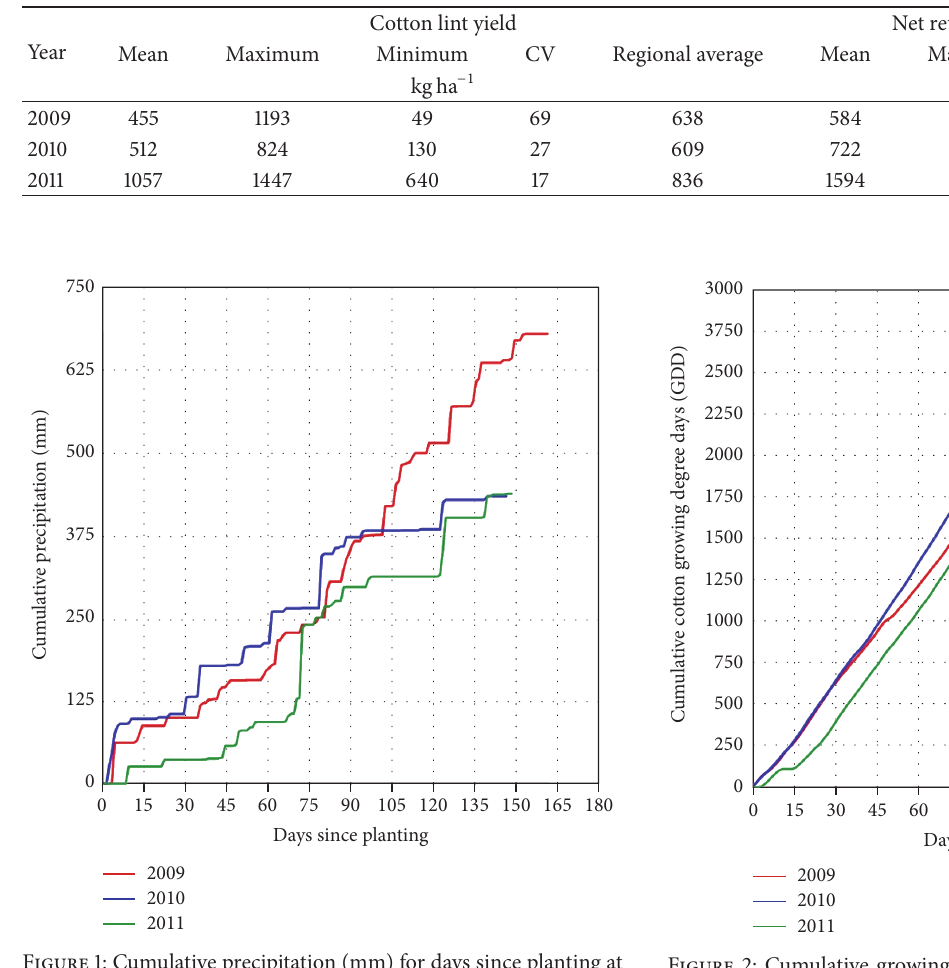
Figure 2: Cumulative growing degree days (GDD) for cotton for days since planting at E. V. Smith Research Center from 2009 to